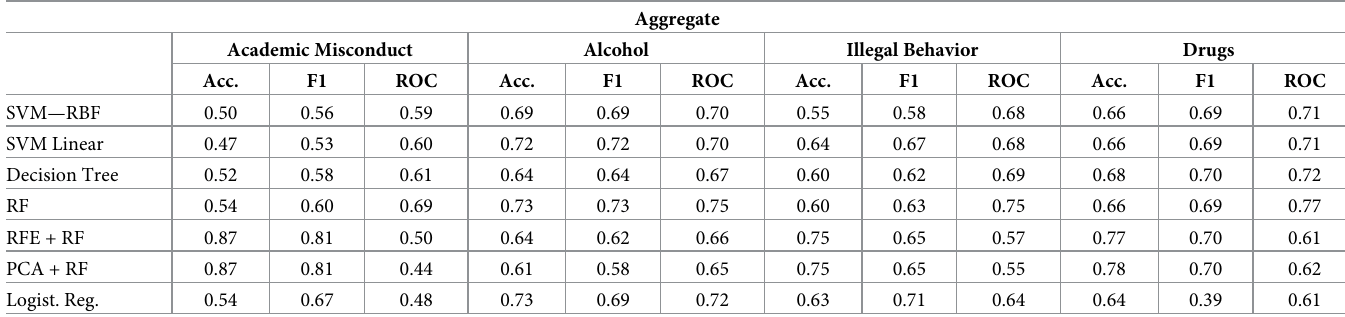
Table 3. Performance metrics across models and behaviors for aggregate FoMO.